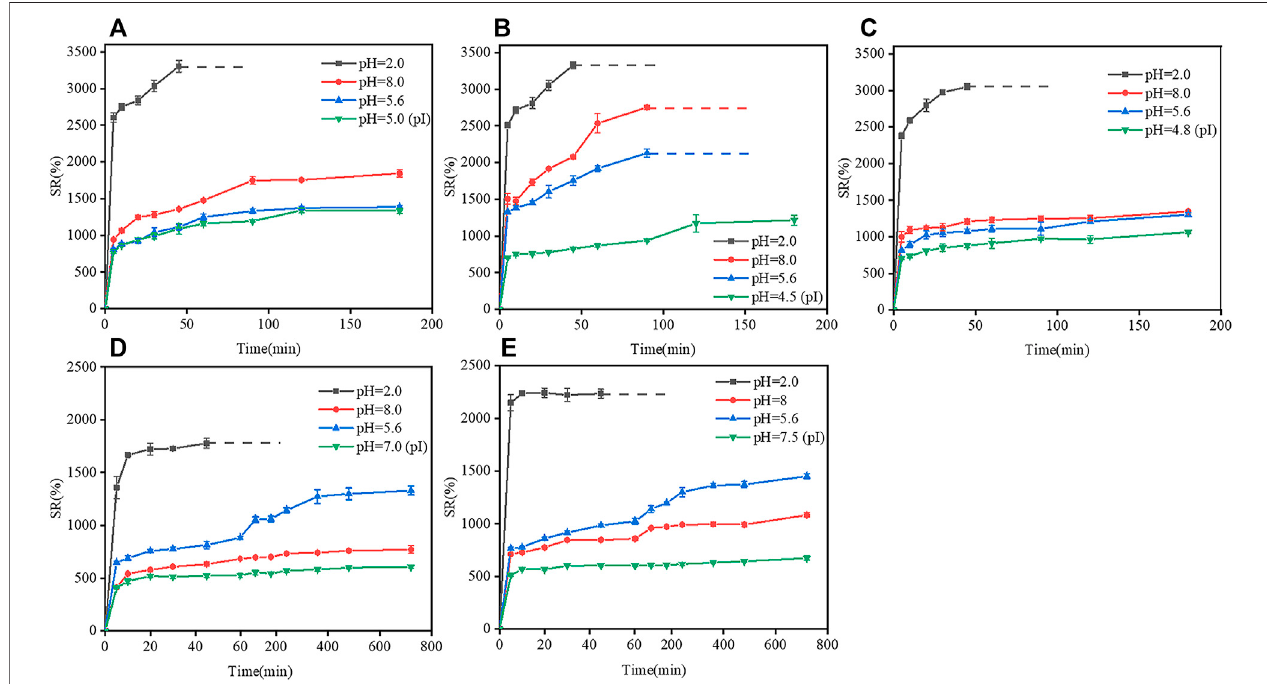
FIGURE 6 | Effects of isoelectric points on the swelling ratio of gelatin fi lms at different pHs. (A) B1 fi lm, (B) B2 fi lm, (C) B3 fi lm, (D) E1 fi lm, and (E) E2 fi lm. Dotted lines indicate that gelatin fi lms were completely dissolved in water.